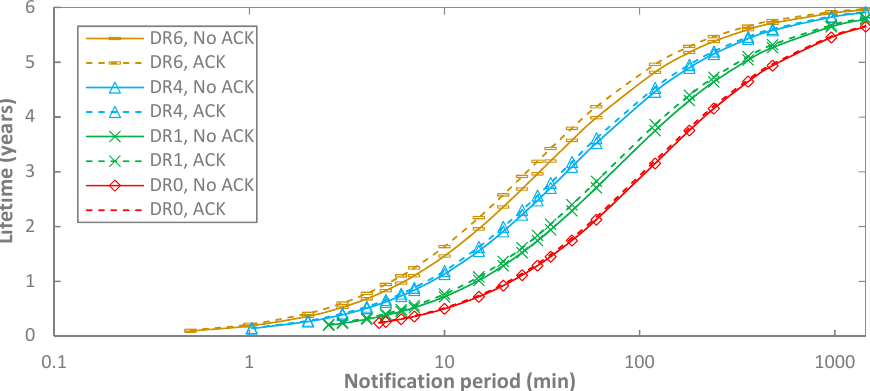
Figure 14. End-device lifetime in acknowledged and unacknowledged transmission, as a function of T Notif , and for different DR settings, BER = 0 and p coll = 0. DR2, DR3 and DR5 are not shown in the figure for the sake of illustration clarity.